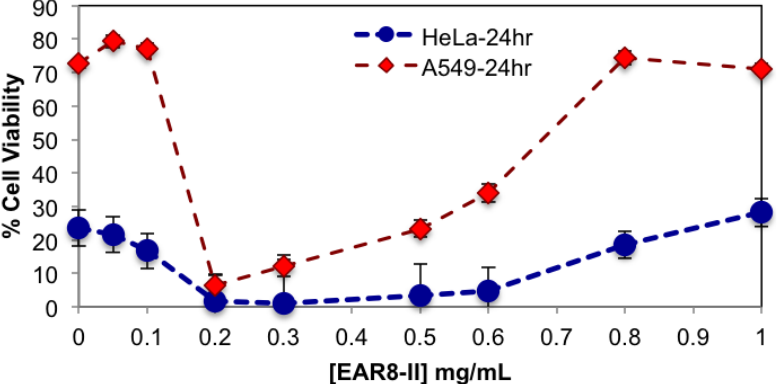
Figure 7. Cellular viability of HeLa and A549 cells treated with the complexes for 24 h at